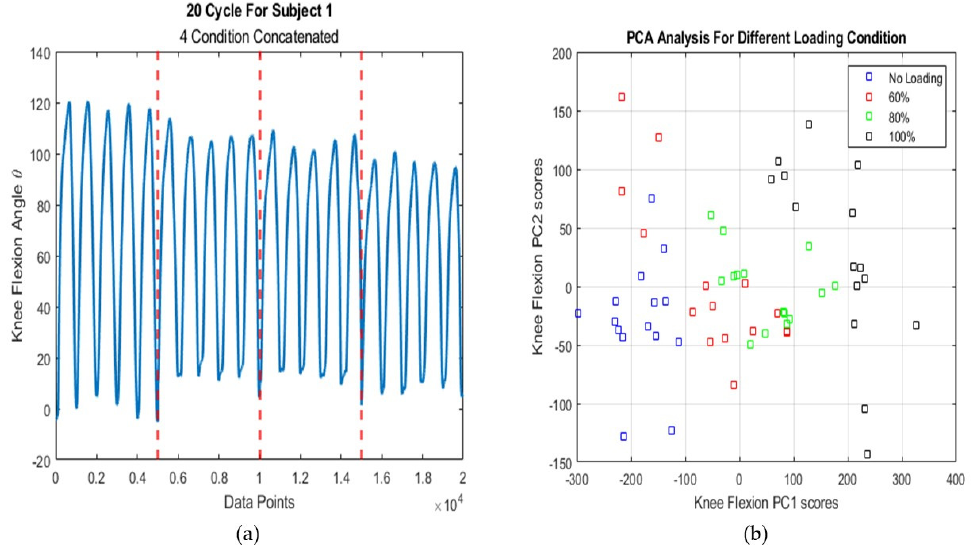
Figure 3. ( a ) Effect of Loading on Kinematics Signal in Knee Joint Flexion; ( b ) PC scores for Different Loading Condition for Knee Joint.